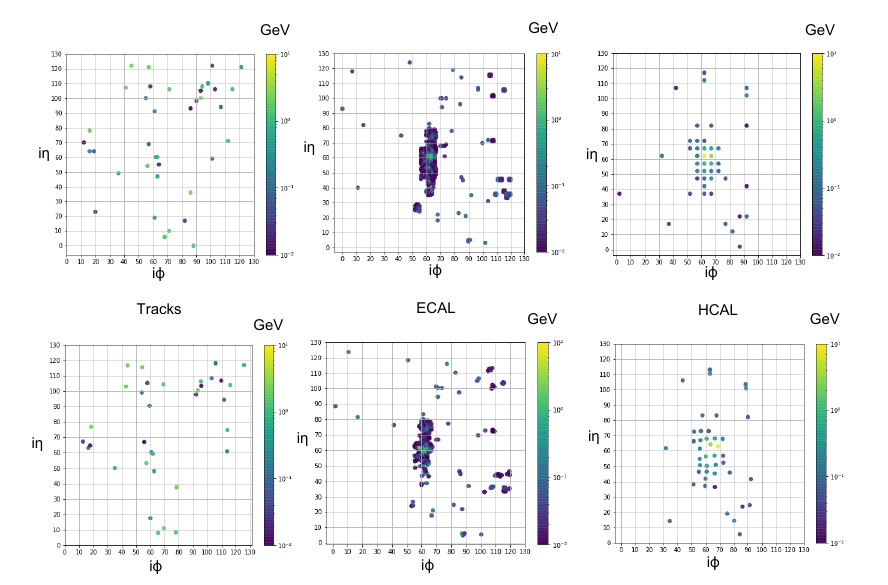
Figure 2. Model architecture of the Graph Variational Autoencoder showing GraphSAGE layers and